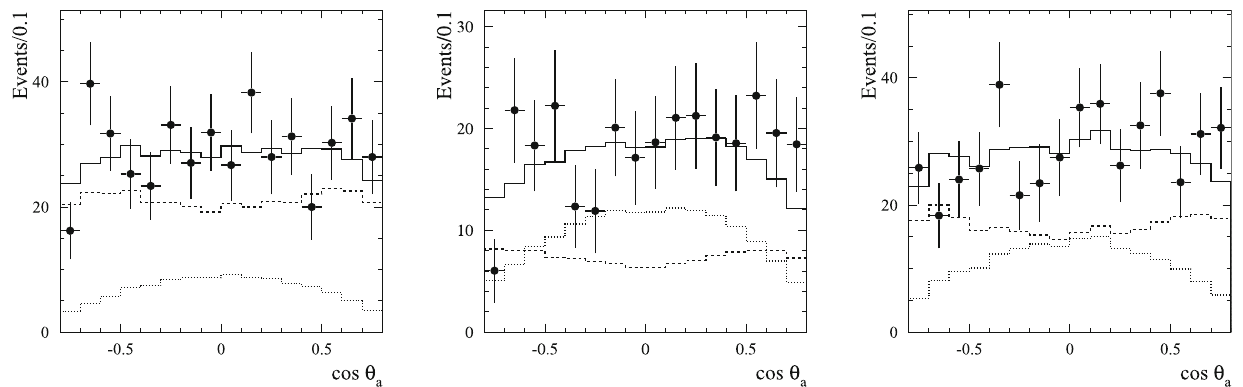
Fig. 6 The cos θ a distributions for data n ¯ n events of the the 2019 run (points with error bars) with E b = 945, 950, and 951 MeV (left panel), with E b = 956, and 963 MeV (middle panel), and with E b = 973,